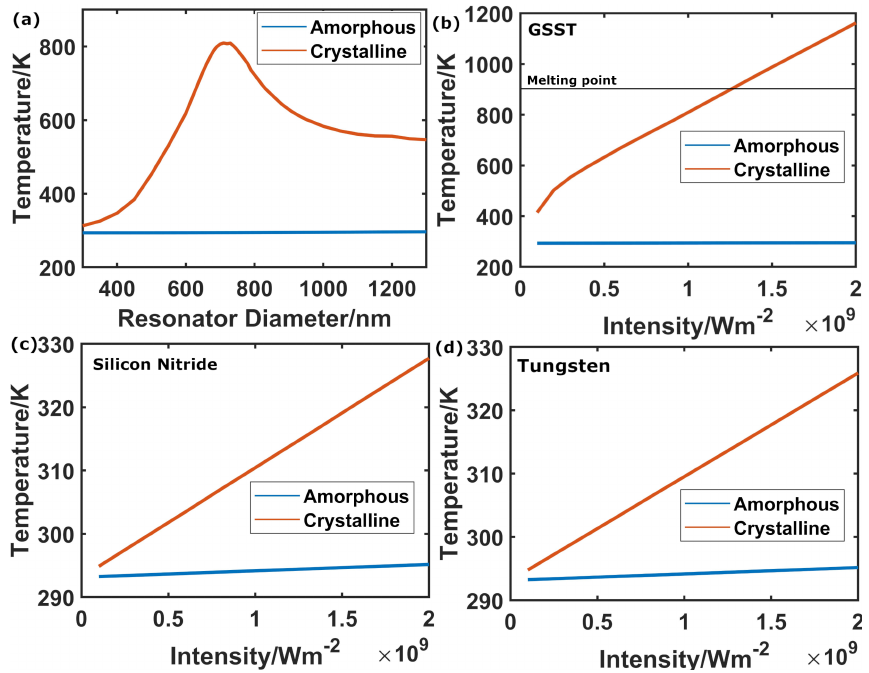
Figure 4. ( a ) Maximum temperatures reached in our model as a function of resonator radius at an incident intensity of 10 9 Wm − 2 with the GSST in both amorphous (blue) and crystalline (red) phases. The maxima occur at 1300 nm diameter for the amorphous and 710 nm for the amorphous. ( b – d ) Maximum temperatures in our model as a function of incident intensity in the ( b ) GSST, ( c ) Si 3 N 4 and ( d ) W layers with the GSST in both amorphous (blue) and crystalline (red) phases. The GSST melting temperature of 903 K imposes the threshold, marked with the horizontal line in ( b ). The melting temperatures of the other materials are beyond the ranges of the respective